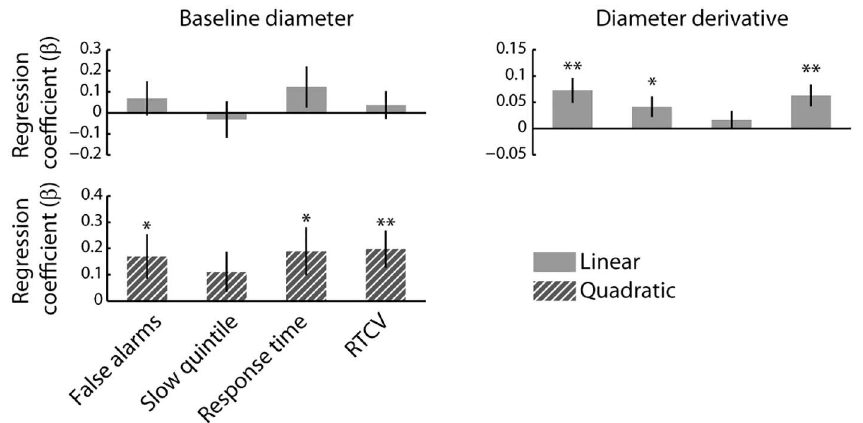
Fig 6. The relationship between pupil diameter and behavior, after statistically controlling for time- on-task. Regression coefficients per pupil measure and behavioral measure with time-on-task includedas a variableof non-interest. Error bars represent the SEM. * : p < 0.05; ** : p <